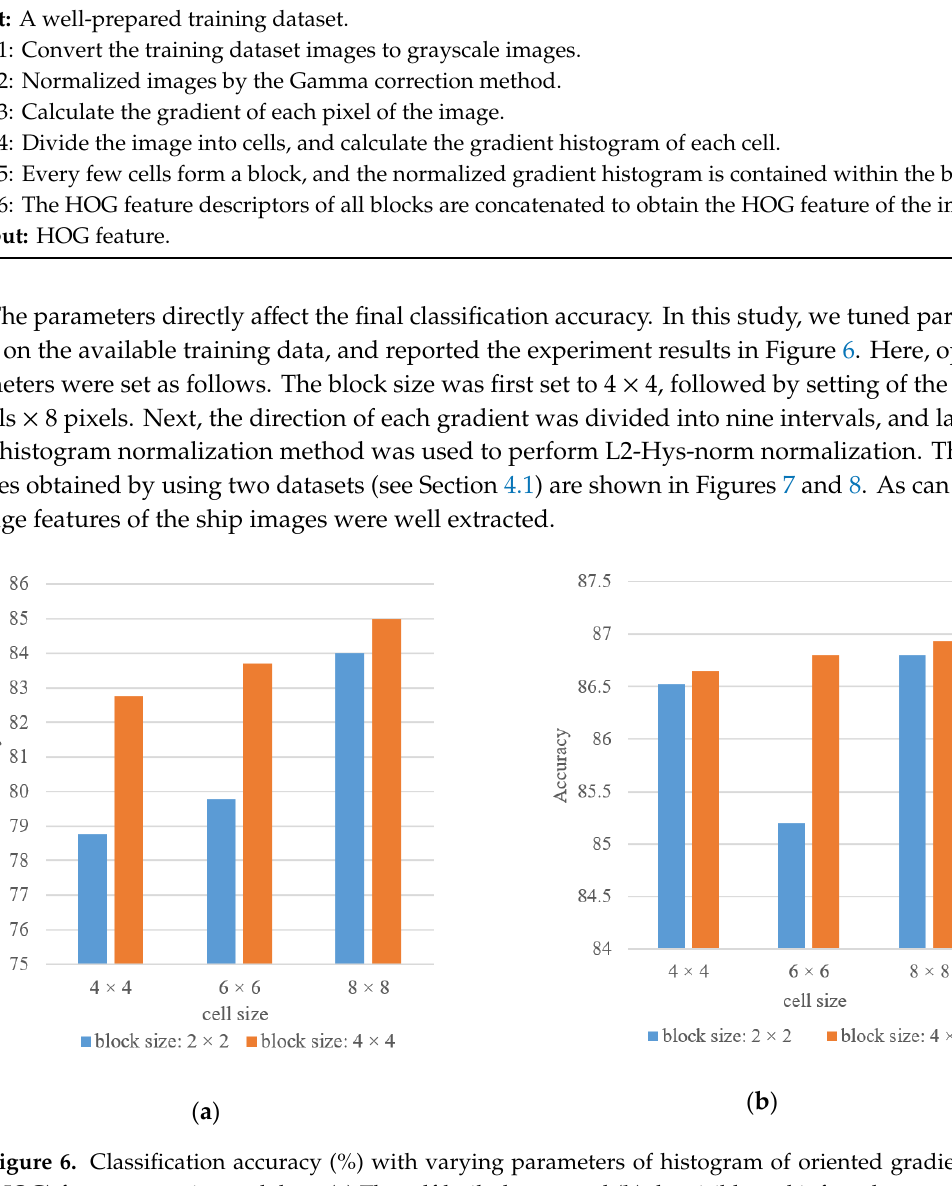
Figure 7. Illustration of HOG feature using the self-built dataset : ( a ) Original image; ( b ) grayscale image; and ( c ) HOG feature.